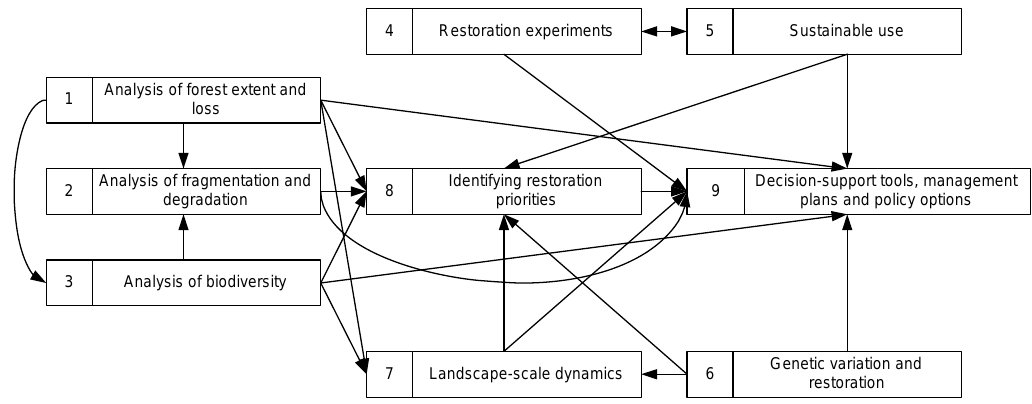
Figure A2.3 . Inter-relationships of different elements (Work Packages, numbered 1-9) of the ReForLan